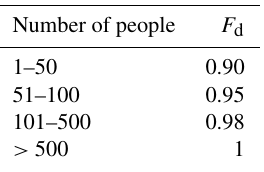
Table 2. A factor characterizing the density of people ( F d ) in rela- tion to the number of people